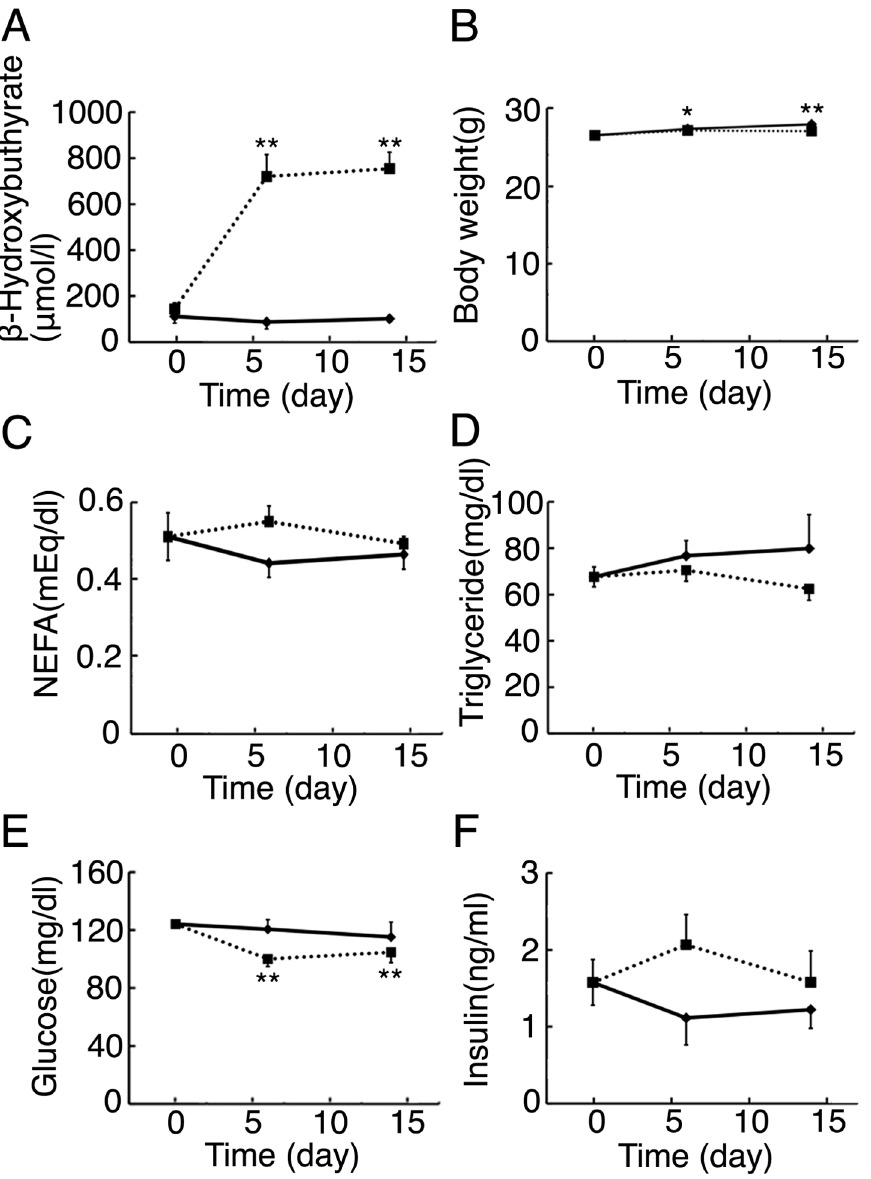
Figure 1. Body weights and blood parameters in mice fed KD. (A) Blood b -hydroxybutyrate levels in 3-month-old mice fed KD for 6 days or 14 days, or NC (n=3–8 per group; **, P , 0.01 vs. day 0). (B) Body weights in 3-month-old mice fed KD for 6 days or 14 days, or NC (n=5–28per group; *, P , 0.05; **, P , 0.01 vs. day 0). (C–F) Blood NEFA, triglyceride, glucose, and insulin levels in 3-month-old mice fed KD for 6 days or 14 days, or NC (n=4–12 per group; **, P , 0.01 vs. day